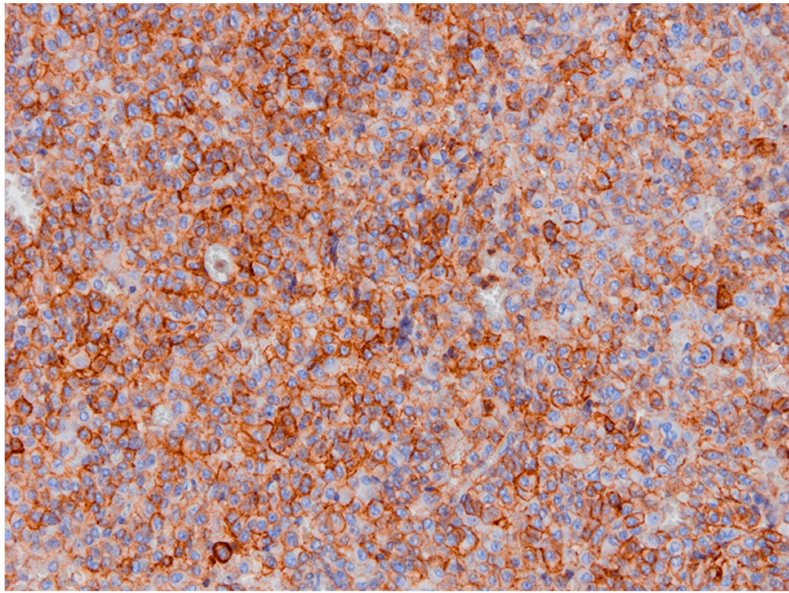
Figure 6. At moderate staining intensity of SSTR, subtype 2 and IRS of 6 can be observed (patient